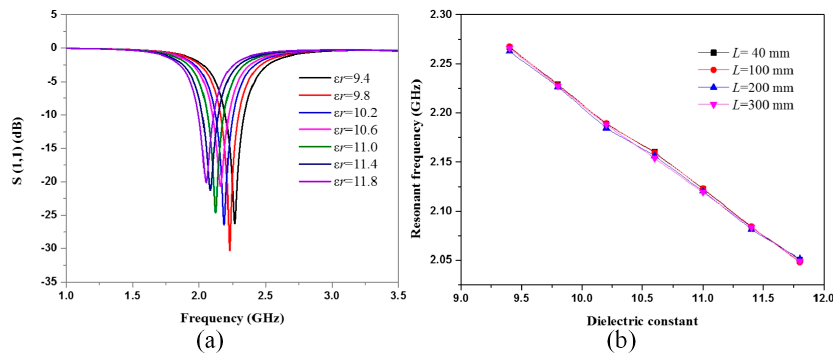
Figure 4. The frequency sweep simulation in HFSS. ( a ) Frequency versus S(1,1) for different dielectric constant of the sensor substrate with L = 40 mm. ( b ) The extracted resonant frequency of the sensor with L = 40 mm, 100 mm, 200 mm, and 300 mm,